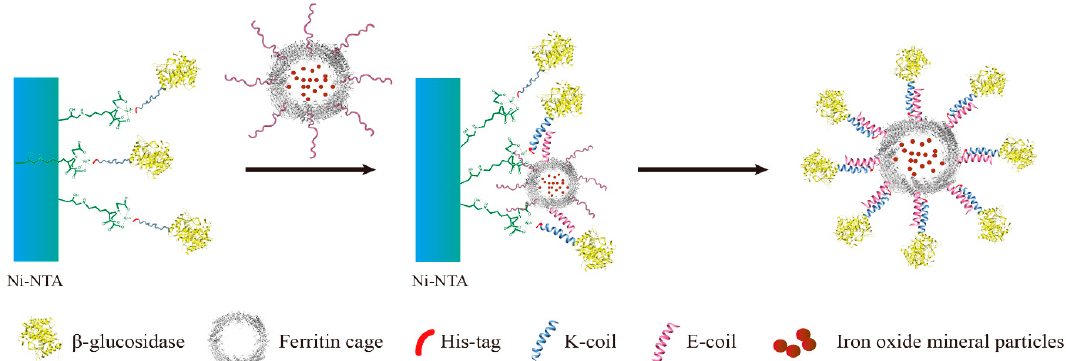
Figure 1. Purification of β -glucosidase and the human H chain ferritin without the sequence of a His-tag (KG-HE) protein complex. A solution containing the N-terminus of β -glucosidase (KG) is added to a Ni-nitrilotriacetic acid (Ni-NTA) column. Only KG binds to the Ni-NTA with its N-terminal His-tag (sequence of KG was ‘(N-terminal) His-tag–K-coil–glucosidase (C-terminal)’). A washing step removes all proteins lacking the His-tag. The solution containing the magnetoferritin of human H chain ferritin without the sequence of a His-tag (HE) is then added. The HE with the C-terminal coiled coil (pink) binds to the N-terminal coiled coil (blue) of KG. After another wash step, the KG-HE complex is eluted from the column using an excess of imidazole. Table 1. Amino acid sequences of E- and